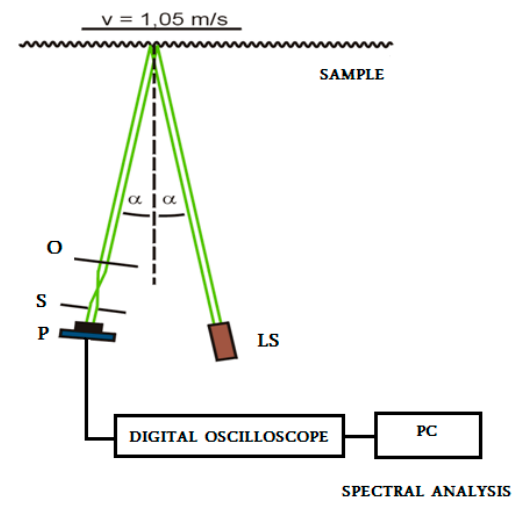
Figure 2. The arrangement of the experiment for surface roughness measurement using spectrum analysis.